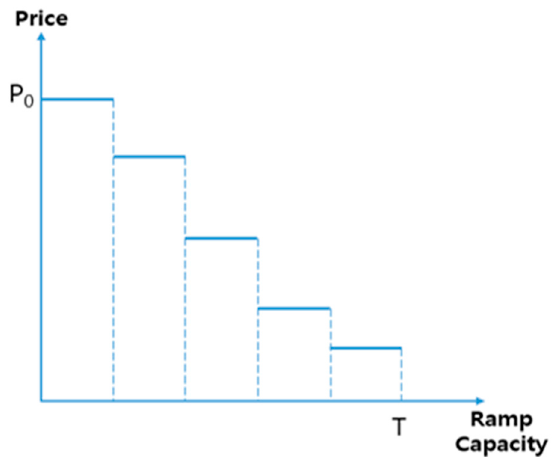
Figure 6. Flexible ramping capacity demand curve.